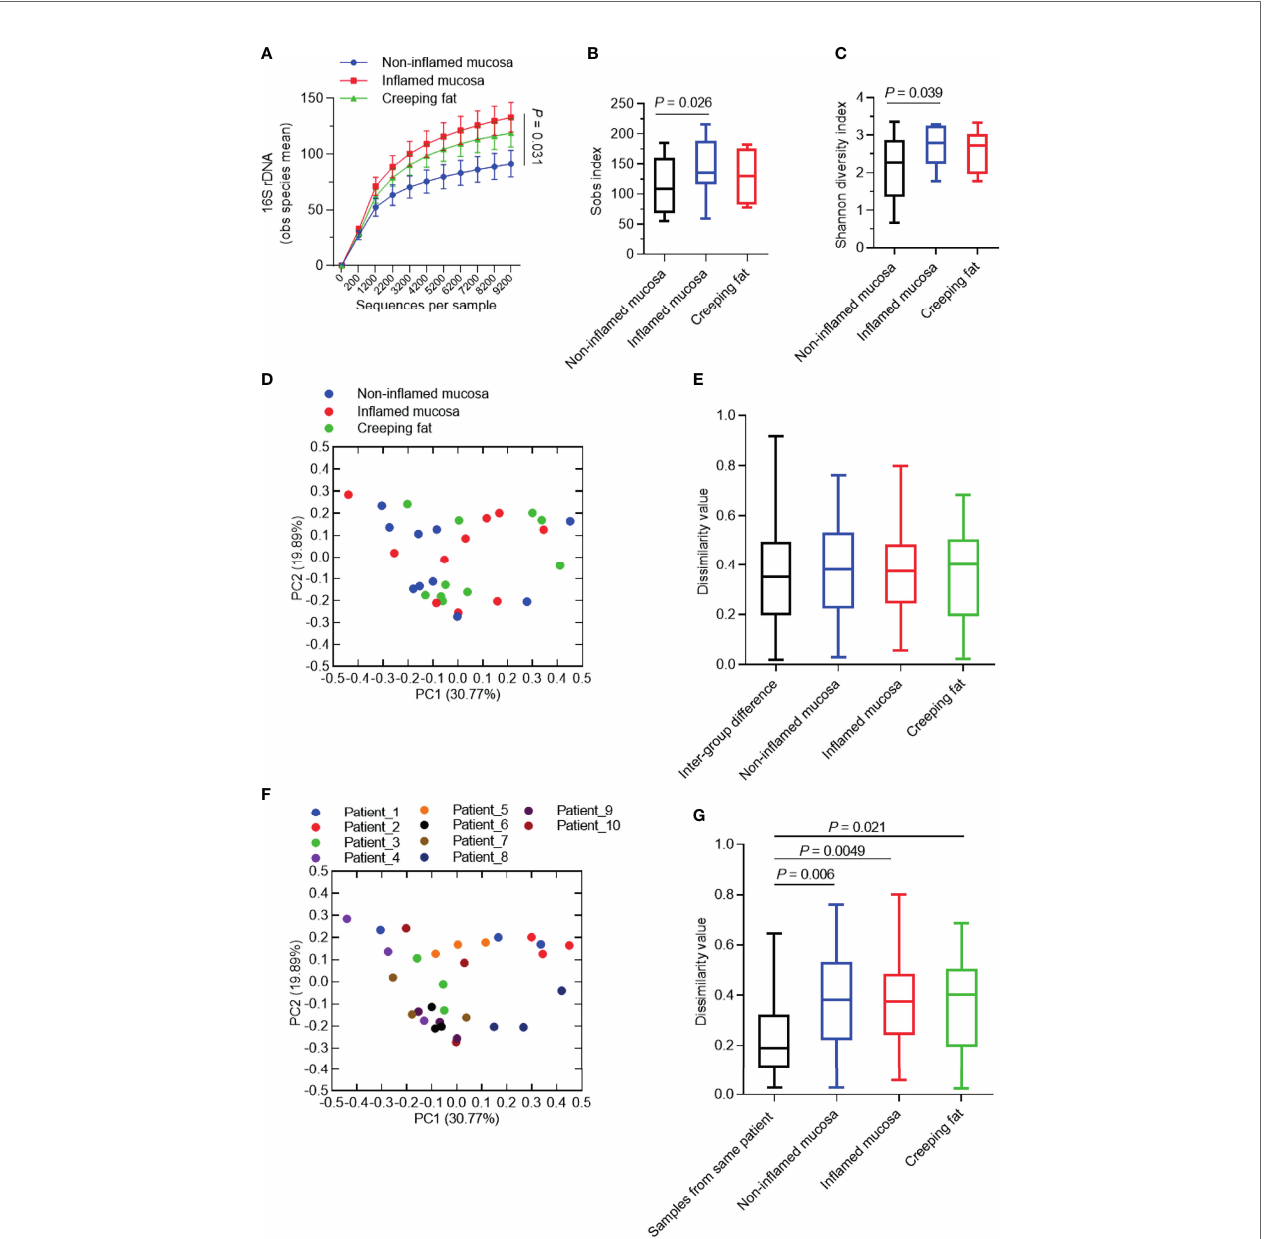
FIGURE 4 | Analysis of the alpha-/beta-diversity of bacteria in different intestinal tissues from CD patients. (A) Rarefaction analysis of observed species mean (obs). (B, C) Shannon diversity index (B) and Sobs index (C) of microbial communities for nonin fl amed mucosa, in fl amed mucosa, and creeping fat. (D, F) Principal coordinate analysis (PCoA) based on the weighted UniFrac difference. Samples were grouped by tissue type (D) or patient (F) . (E, G) Quanti fi cation of weighted UniFrac distances in (D, F) , respectively. The fi ve lines of the boxplot from bottom to top represent the minimum value, fi rst quartile, median, third quartile, and maximum value. Data are presented as the mean ± 95% CI; p -value calculated by paired Student ’ s t